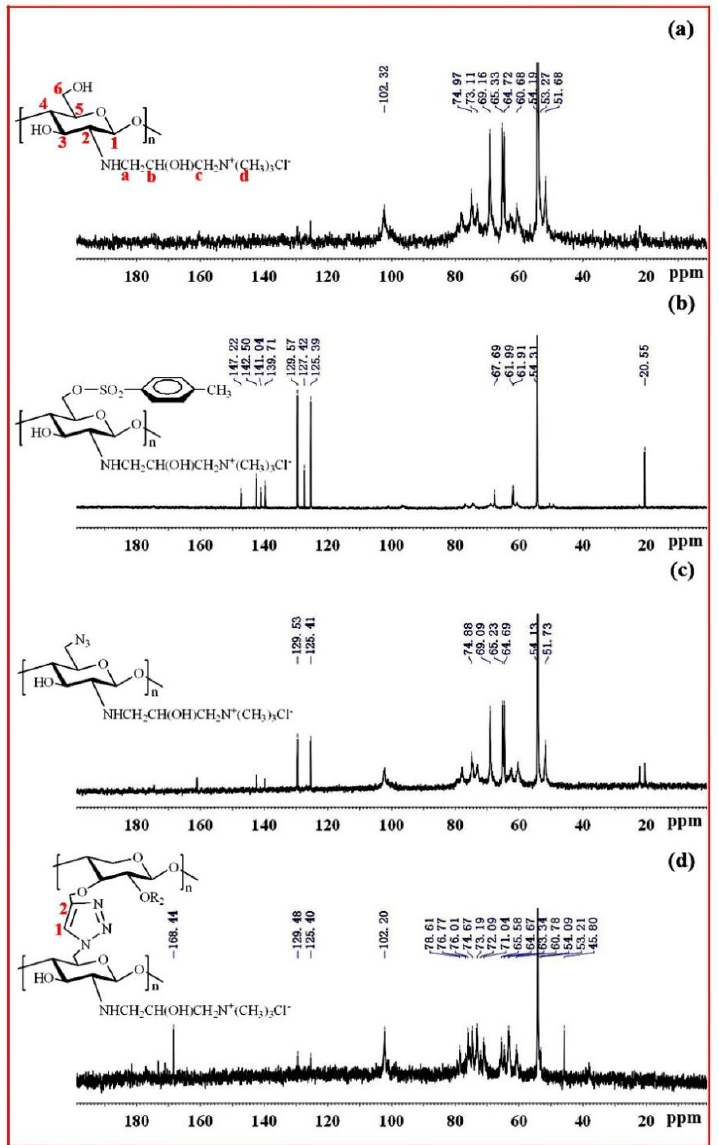
Figure 5. 13 C NMR spectra of ( a ) QCS, ( b ) QCS-6-OTs, ( c ) QCS-N 3 and ( d ) Xylan-click-QCS.